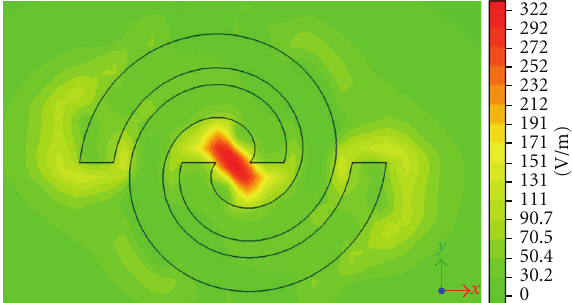
Figure 4: Electric field distribution on Archimedean spiral antenna at 184 THz due to x -polarized unity strength plane wave incidence.